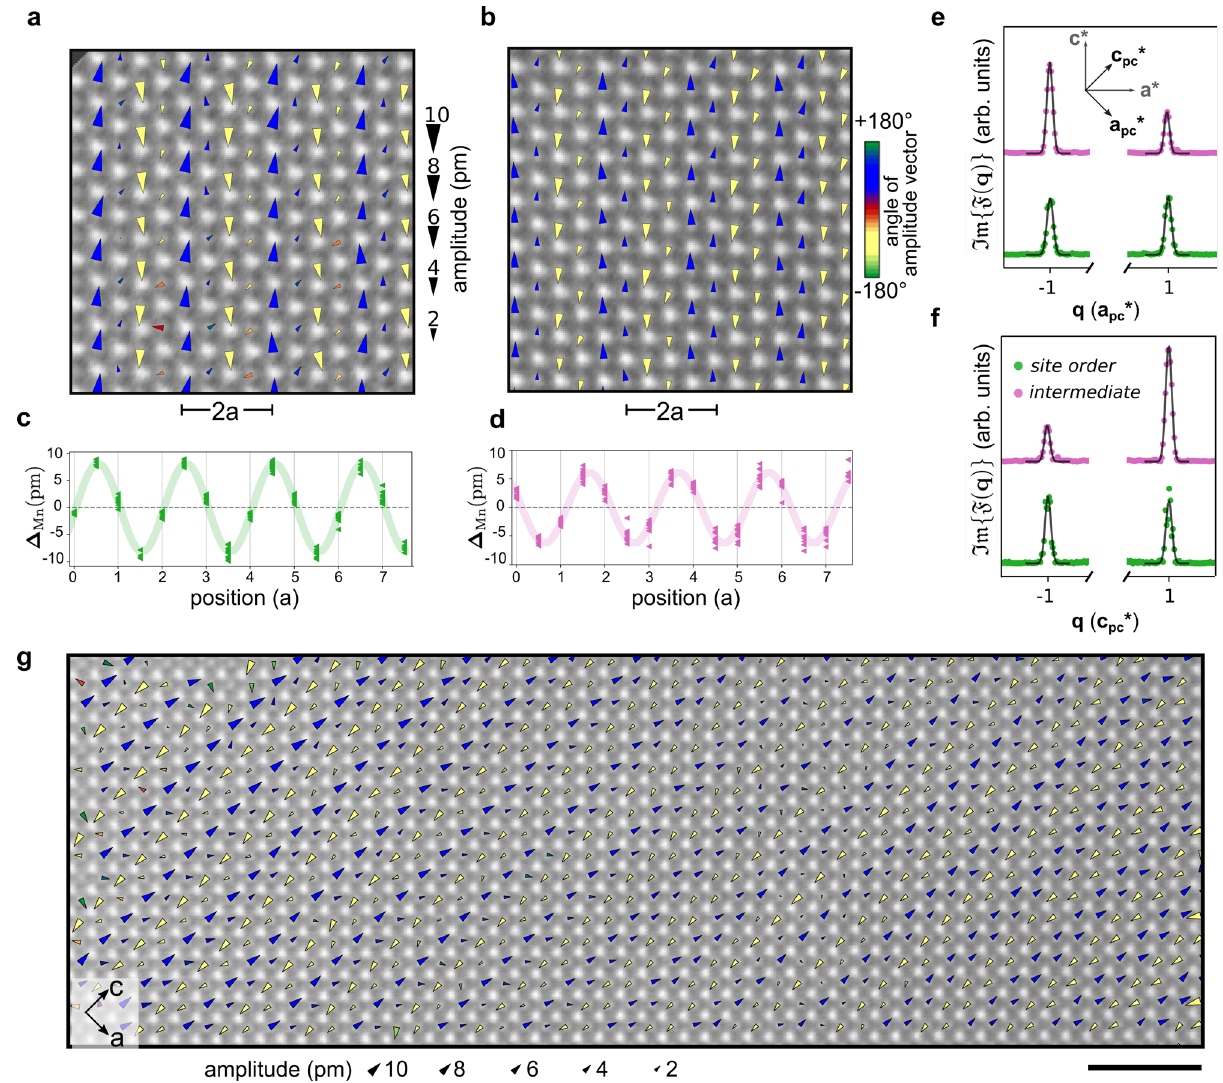
Fig. 3 Nanoscale coexistence of site order and noncentrosymmetric intermediate order. a Map of periodic lattice displacements of manganese atomic columns ( Δ Mn ). The area of the arrows scales with the amplitude of the distortion and the color represents the angle relative to the wavevector direction. In this case, the colors (blue/yellow) indicate a transverse polarization of the displacements ( + 90°/ − 90°). The displacement pattern within the sub-region is consistent with site-centered order; one Mn sublattice shows large displacement amplitude while the other shows much smaller displacements. b Periodic lattice displacement map in another sub-region shows displacements on both sublattices. Further, the sublattice displacement amplitudes are not equal which indicates intermediate order. c Mn displacements (dots) and sinusoidal envelope function (line) in the site-centered phase. d Mn displacements (dots) and sinusoidal envelope function (line) in the intermediate phase. e , f Line cuts across the imaginary part of local Fourier transforms, Im f F ð q Þg , along the pseudocubic directions a (cid:2) and c (cid:2) . The site-centered phase (green) maintains ± q symmetry whereas the intermediate phase (magenta) pc pc shows clear differences between the ± q peaks, an indication that the latter phase breaks inversion symmetry. g , Large fi eld-of-view map of periodic Mn displacements shows a transition from site-centered order (left side) to intermediate order (right side). The scale bar corresponds to 2